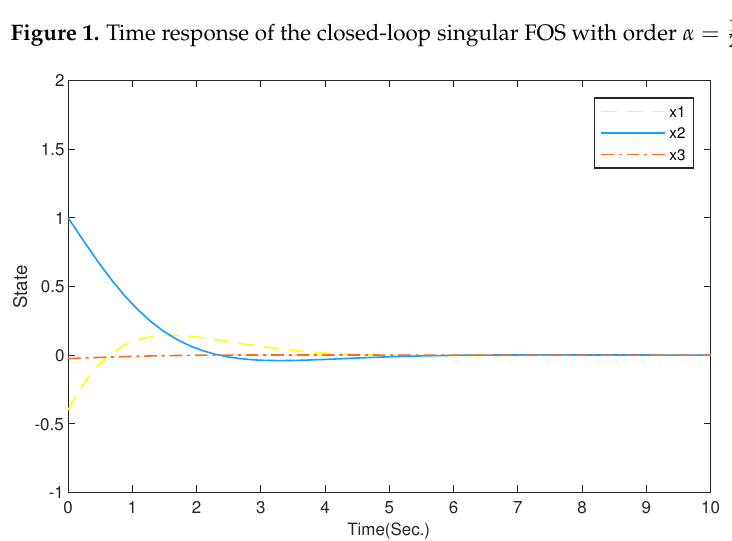
Figure 2. Time response of the closed-loop singular FOS with order α = 1.